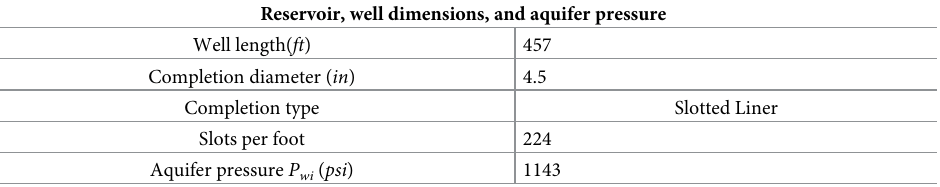
Table 1. Physical properties obtained from field measurements and used in the CFD reservoir-scale